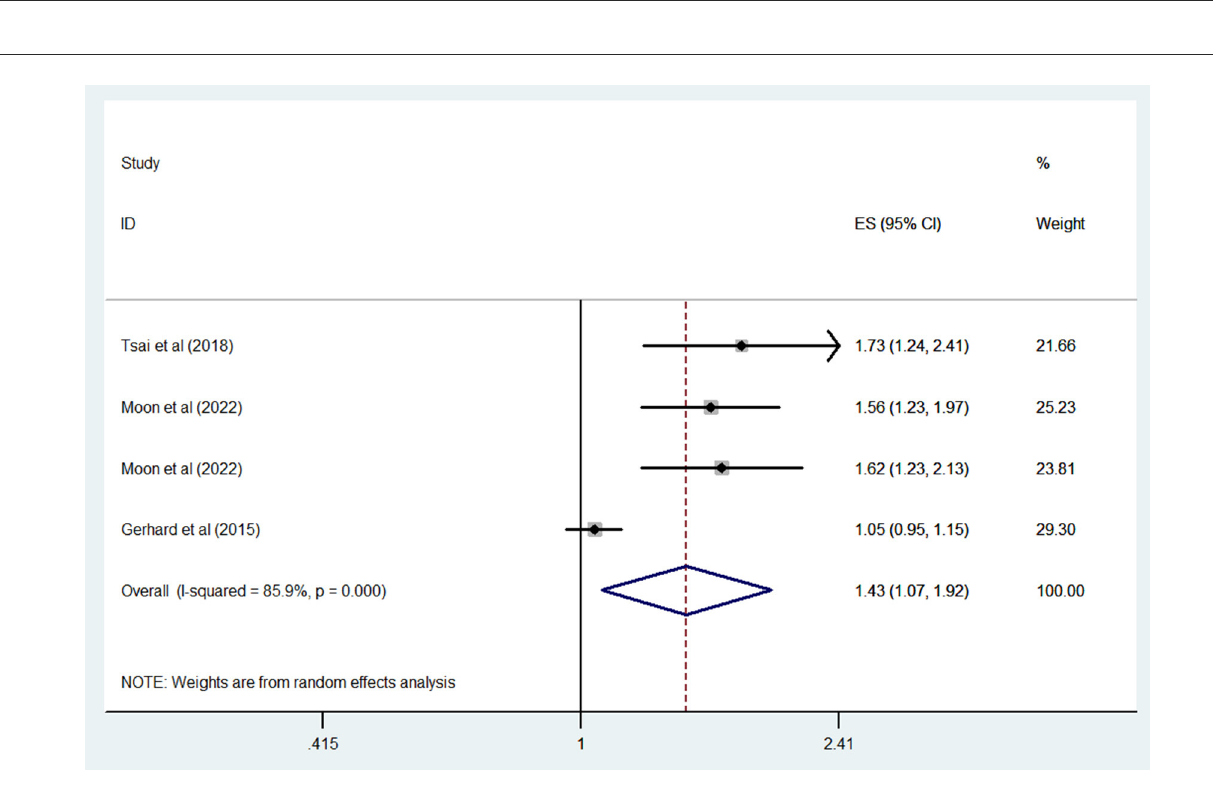
FIGURE3 Forest plot of the overall risk of dementia in relation to ASMs use among patients with bipolar